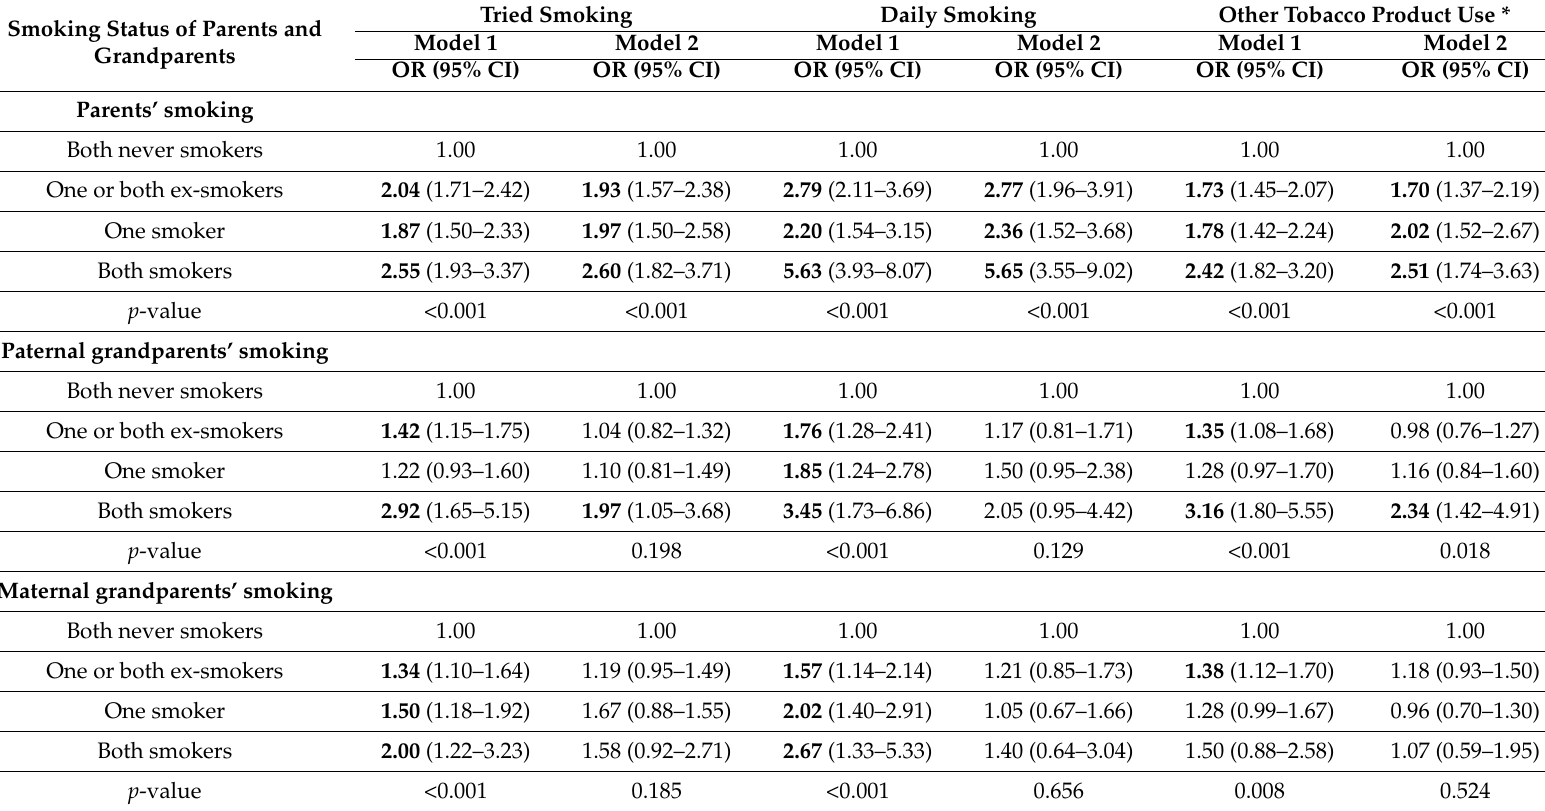
* Snus, water pipe and electronic cigarettes; † Model 1: adjusted for age and sex; Model 2: parents’ and grandparents’ smoking statuses included simultaneously in the model, adjusted for age, sex and parents’ education and employment status; Note: OR is given in boldface when it indicates a statistically significant ( p < 0.05) difference from the odds of the reference